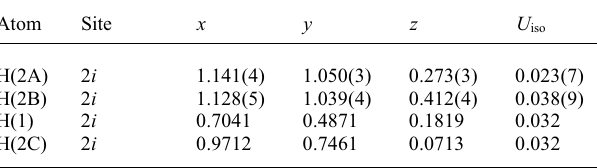
Table 3. Atomic coordinates and displacement parameters (in Å 2 ) .